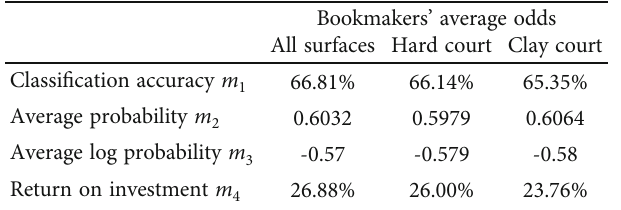
Table 8: Measures of predictive performance for bookmakers ’ average odds.